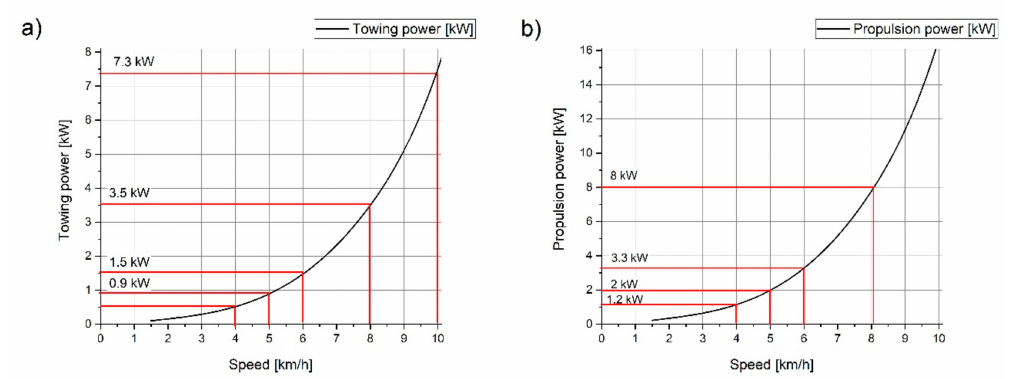
Figure 4. Graph of the power demand of the Motława II ferry as a function of speed: ( a ) Towing power graph, ( b ) power demand